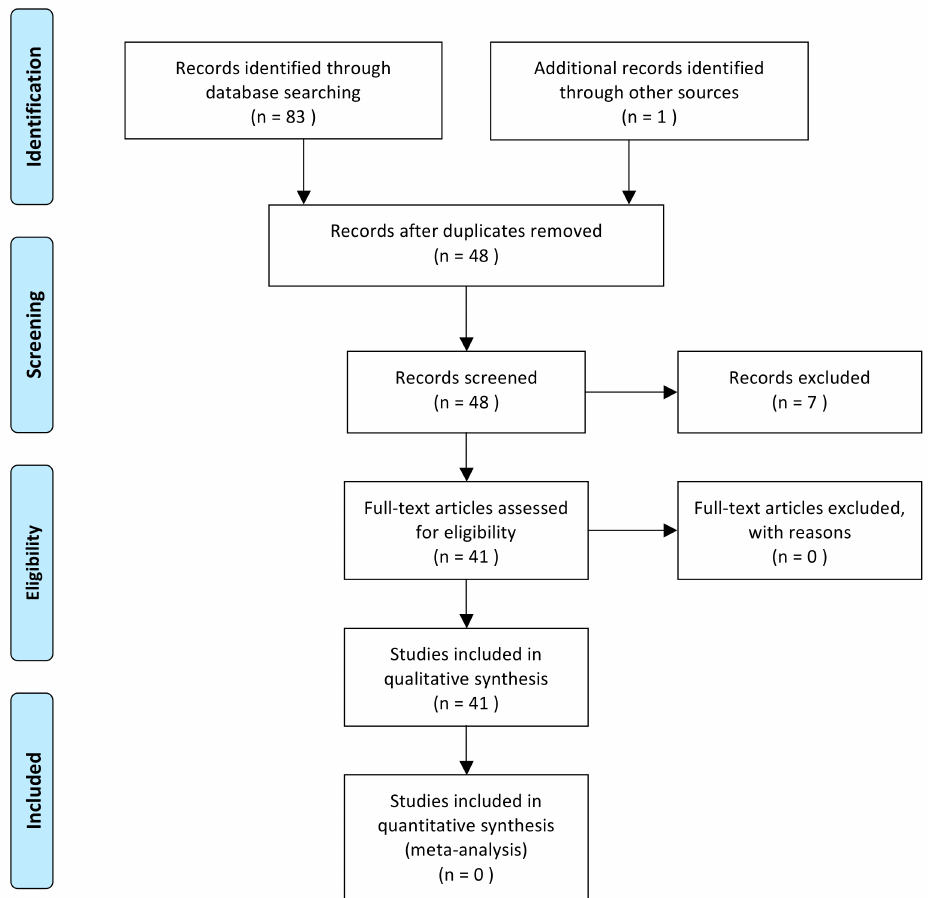
Figure 1. Study selection flowchart for this systematic review (a color figure can be viewed at